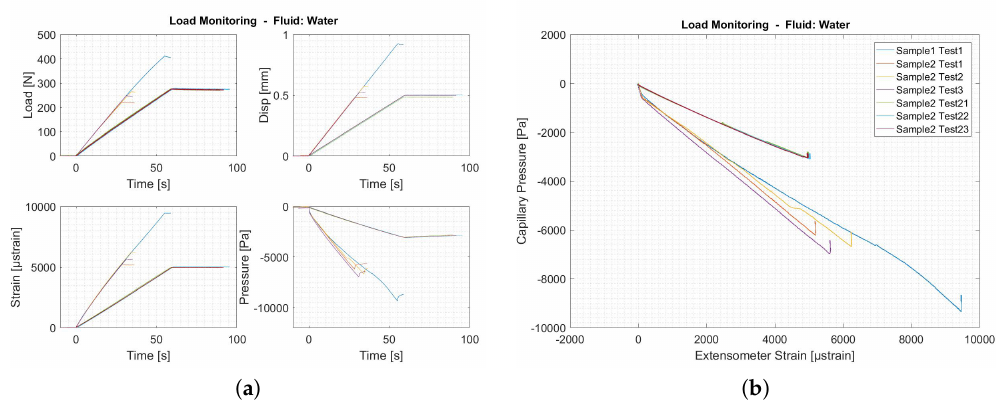
Figure A2. Tensile testing results: Load monitoring system with capillary filled with water is compared to extensometer strain measurements. ( a ) Raw data ( b ) Capillary pressure of the load monitoring system compared to the extensometer